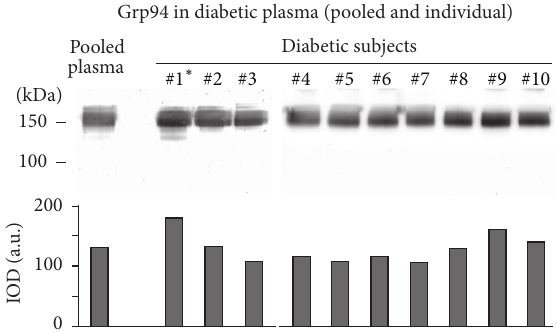
Figure 1: Grp94 is detected in plasma of diabetic subjects. Plasma sampleswereprocessedasdescribedinSection 2,and7.5 𝜇 gproteins of each sample loaded onto a 10% polyacrylamide gel without reducing treatment. Pooled plasma was obtained by mixing an equal protein content of any single plasma sample. Proteins were blotted onto a PVDF membrane and probed with anti-Grp94 Abs. Cross- reactivity for secondary anti-human Abs was excluded by exposing the membrane to secondary Abs before the incubation with primary Abs. Densitometric analysis of Grp94-positive bands is reported below (IOD, integrated optical density). ∗ Subject whose plasma was also analyzed